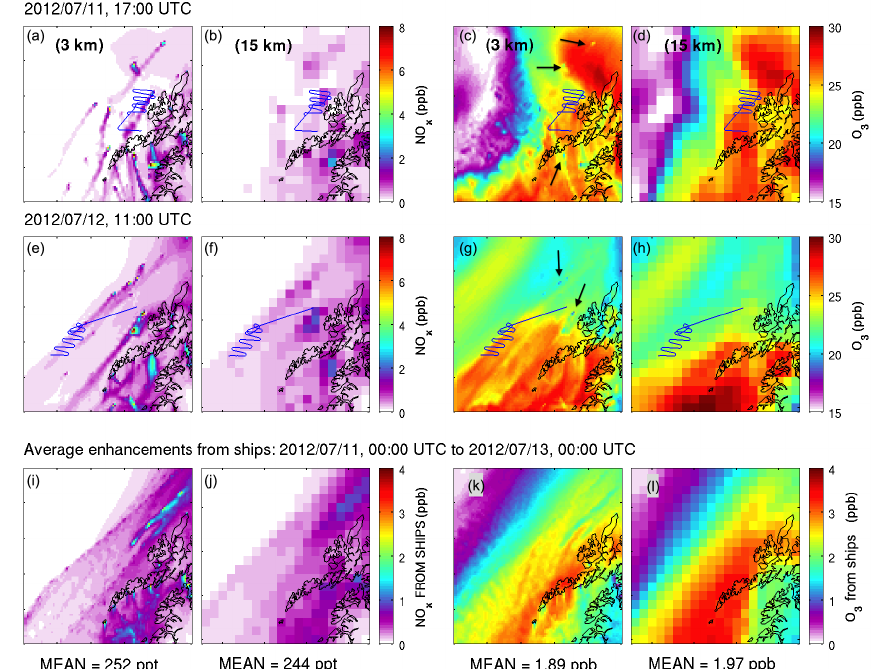
Figure 5. Snapshots of model predicted surface NO x and O 3 from the CTRL3 (3km) simulation (a, c, e, g) and the CTRL (15km) simula- tion (b, d, f, h) during the flights on 11 and 12 July 2012. Model results for the CTRL3 simulation are shown over the full model domain. CTRL run results are shown over the same region for comparison. The aircraft flight tracks are indicated in blue. On panels (c) and (g) , black arrows indicate several areas of O 3 titration due to high NO x from ships. (i, j) NO x and (k, l) O 3 2-day average surface enhancements (00:00UTC 11 July 2012 to 00:00UTC 13 July 2012) due to shipping emissions, (i, k) CTRL3 simulation, (j, l) CTRL simulation. The 2-day average enhancements of NO x and O 3 over the whole area are given below each respective